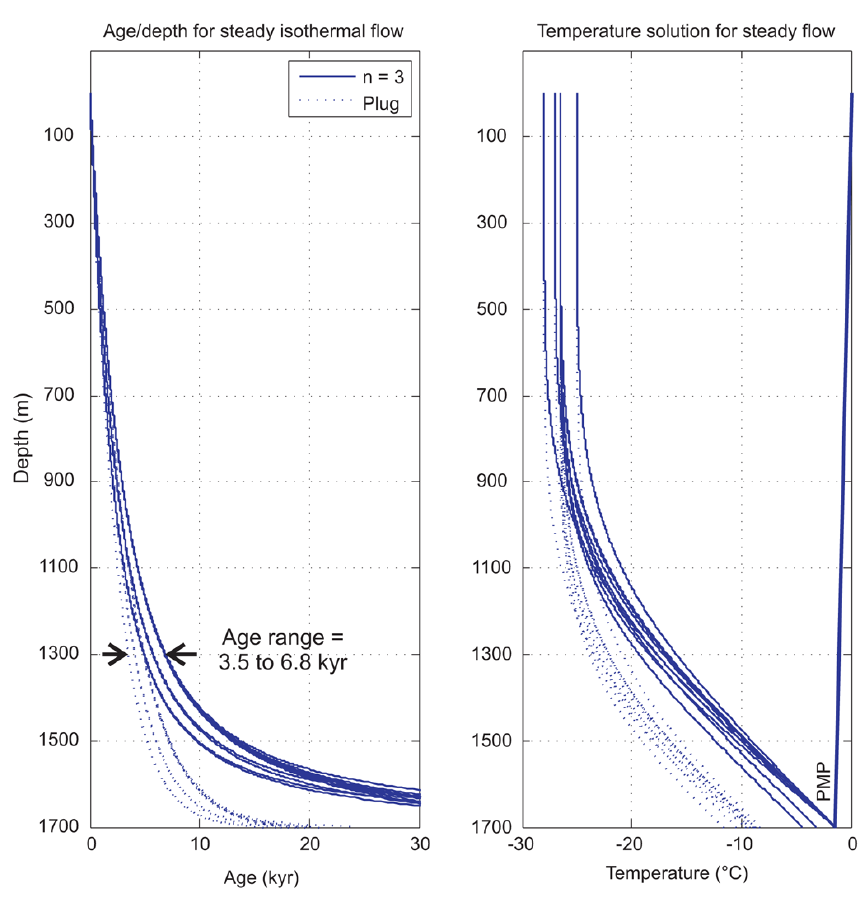
Fig. 5. Age-depth curves computed from a one-dimensional thermo-mechanical model (Hindmarsh, 1999) for line J501. The suites of curves were computed by varying the accumulation rate, geothermal heat flux and surface temperature across ranges expected for the area. The modelled ages for the deepest continuous radar reflector on line J501 fall in the range 3.5 to